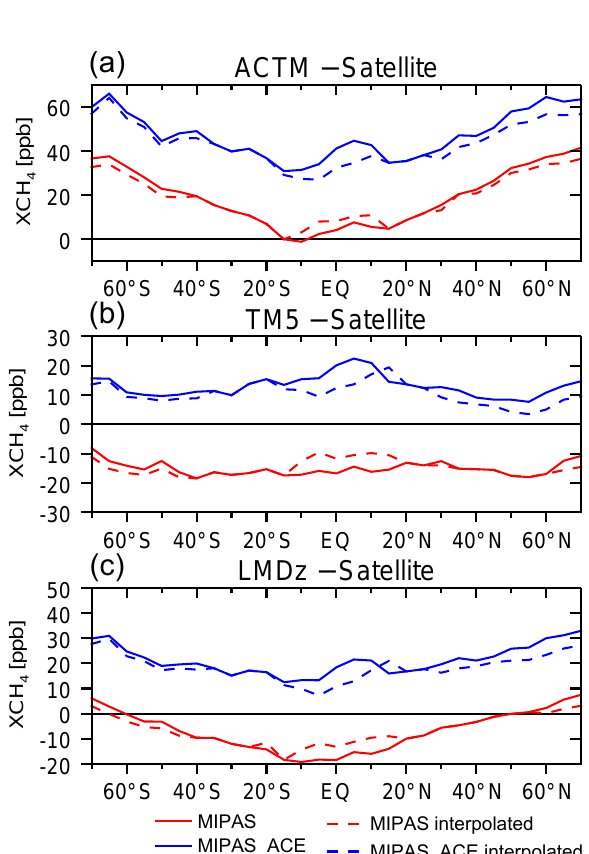
Figure 5. Zonal XCH 4 differences resulting from model–satellite differences of stratospheric CH 4 volume mixing ratios. Mean XCH 4 differences are shown as solid lines for the summer period (June, July, and August) and as dashed lines for the winter period (December, January, and February).